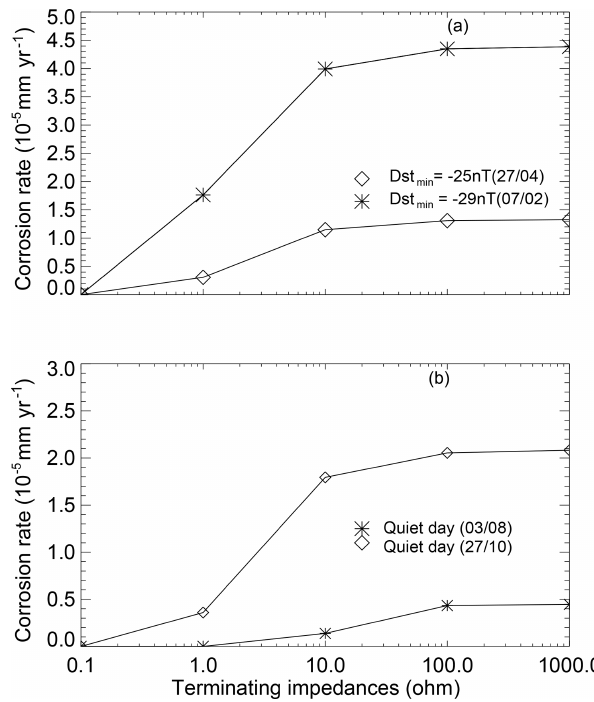
Figure 7. Corrosion rate as a function of the terminating impedances for weak geomagnetic storms (a) and quiet days (b)